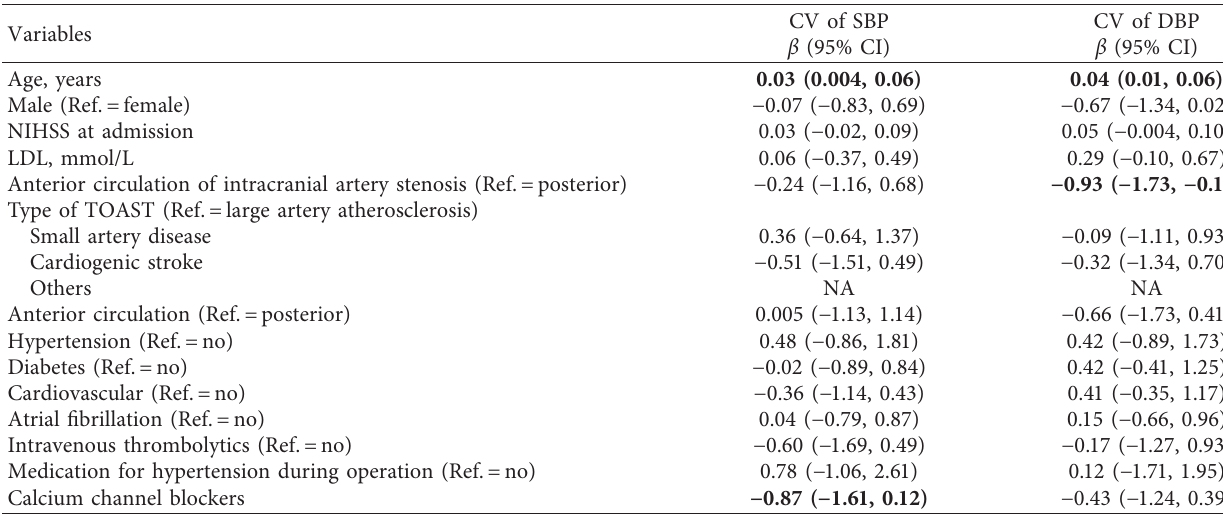
Table 2: Univariate analysis for effectors 1 of coefficient of variance (CV) of BP in patients receiving angiography examination within 3 days after disease onset.